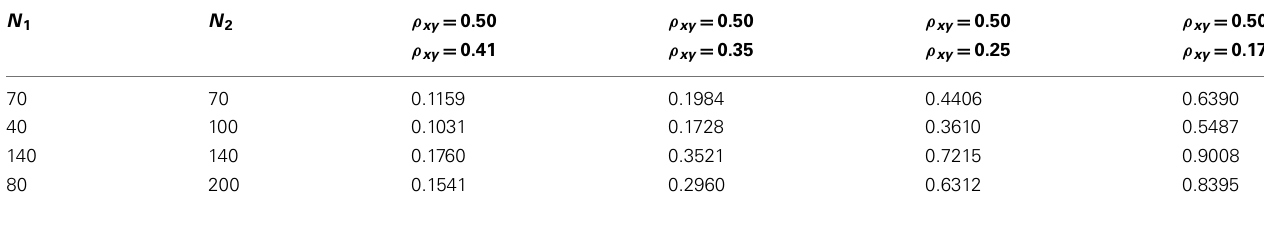
Table 5 | Moderated